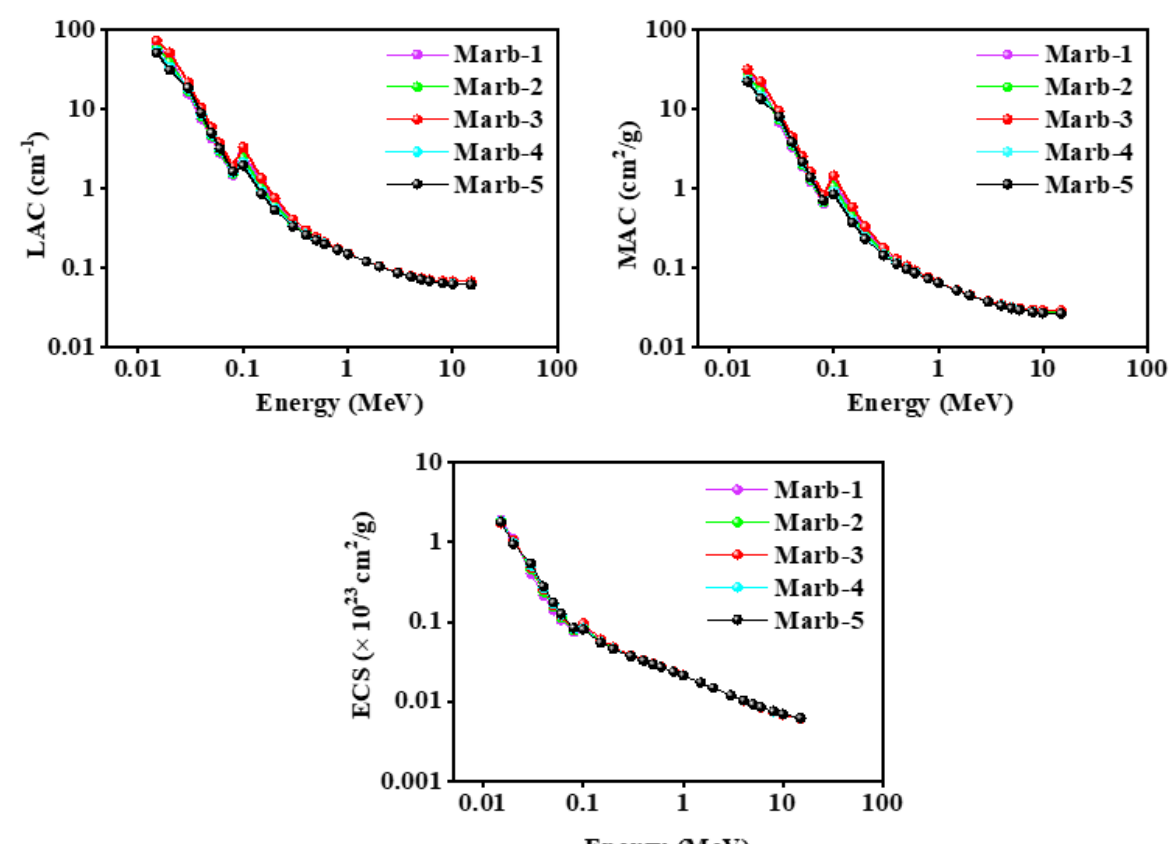
Figure 7. The theoretical values of LAC, MAC, and ECS of the prepared composites are within the energy limit of 0.015 MeV to 15 MeV.